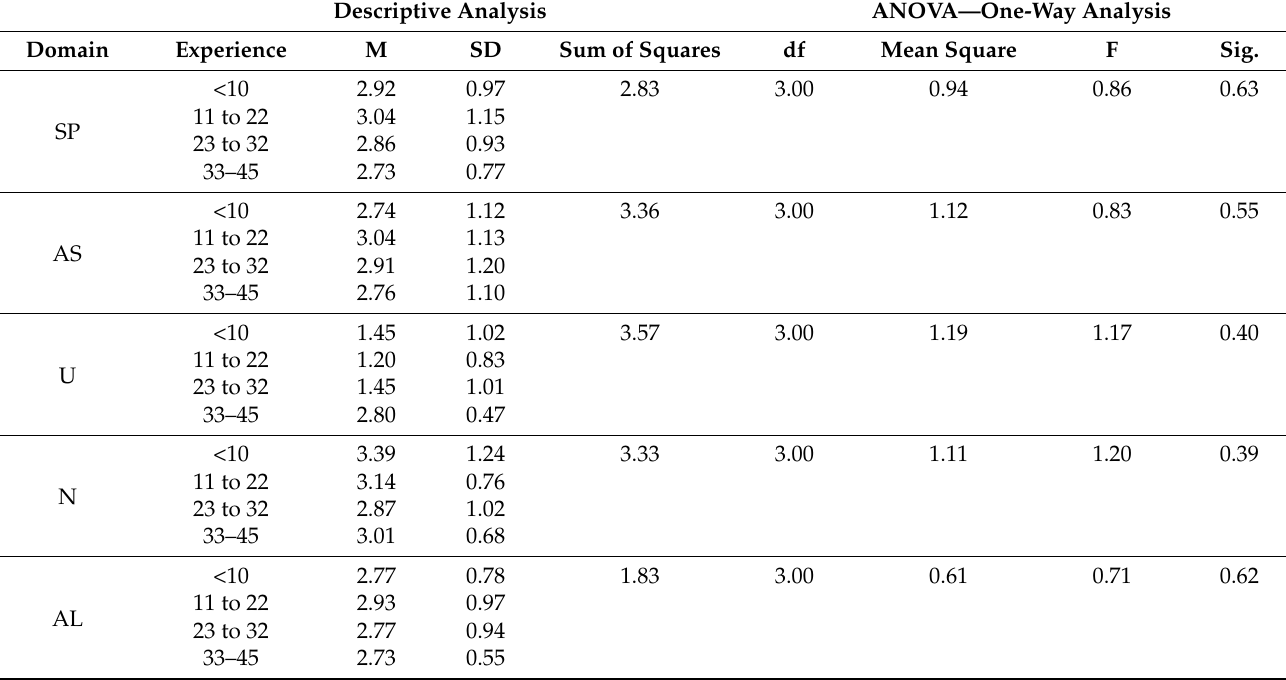
Table 5 delineates the descriptive and one-way ANOVA analysis comparing the five TLS domains by years of teaching experience. Table 5. Descriptive and one-way analysis of toxic leadership domains and teaching